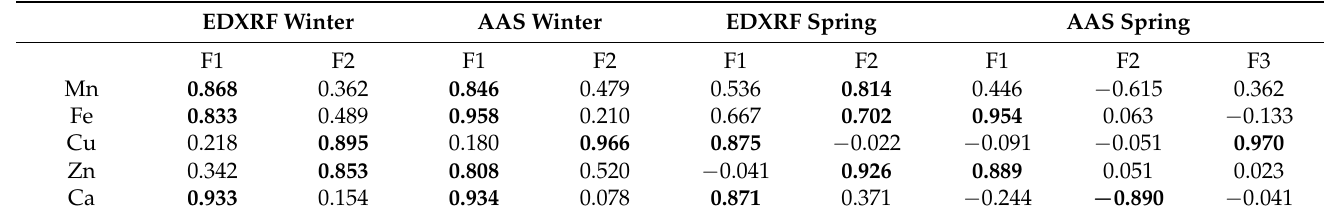
Table 10. Factor loadings matrix for the PM10 chemical composition obtained after applying the factor